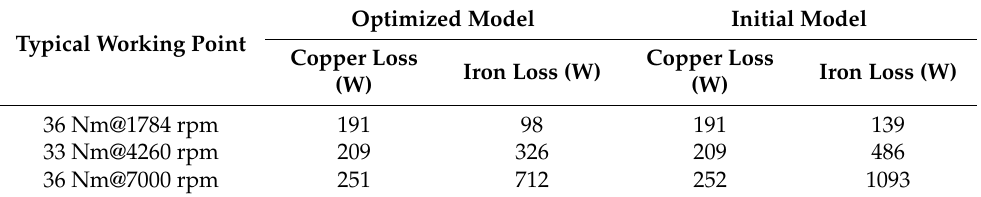
Table 8. Comparison of typical point losses of motor.